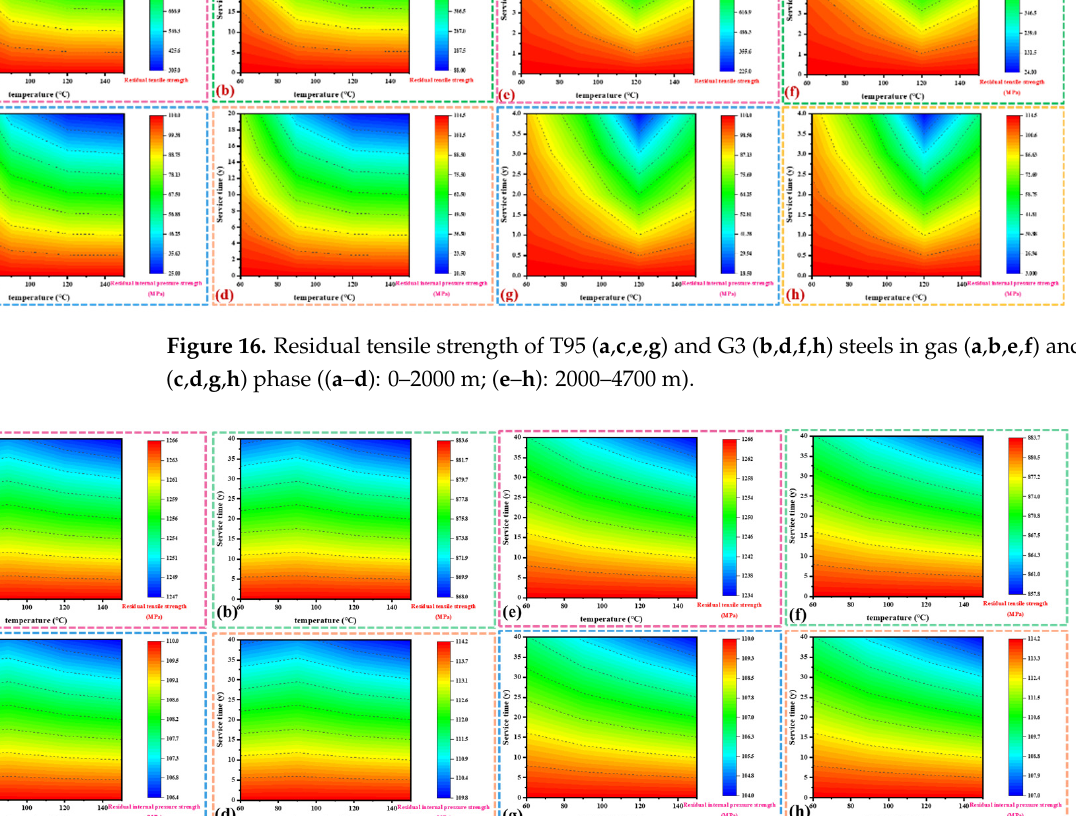
Figure 18. The safe service life of T95 steel in the gas ( a ) and liquid ( b ) phases. 3.3.2. Service Life of Tubing Considering Pitting Corrosion Due to the serious pitting corrosion of T95 steel in a liquid environment, the safe service life of tubing can be predicted according to the local corrosion rate. Figure 19 de ‐ scribes the residual tensile strength and residual internal pressure strength of T95 steel considering the pitting corrosion in gas and liquid phases at various temperatures, and the safe service life of T95 steel is determined according to the critical internal pressure and critical tensile safety factor, as shown in Figure 20. For the sake of safety, the safe service life of T95 steel is only one year.